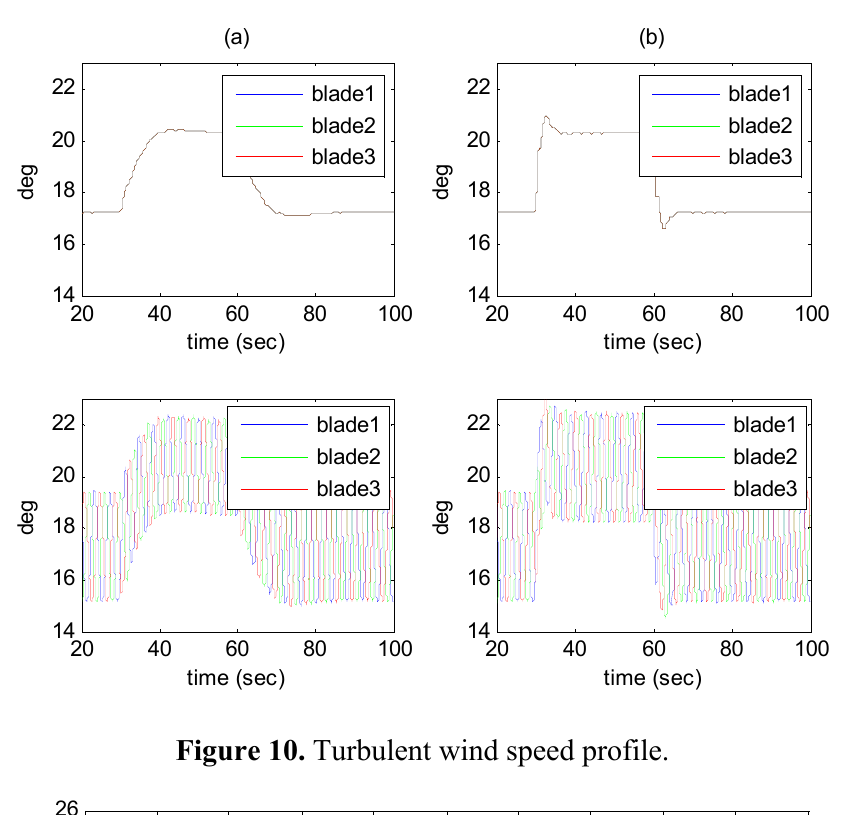
Figure 9. Responses of pitch commands (without IPC (top) and with IPC (bottom)): ( a ) more weighting on blade moment; ( b ) more weighting on rotor speed.